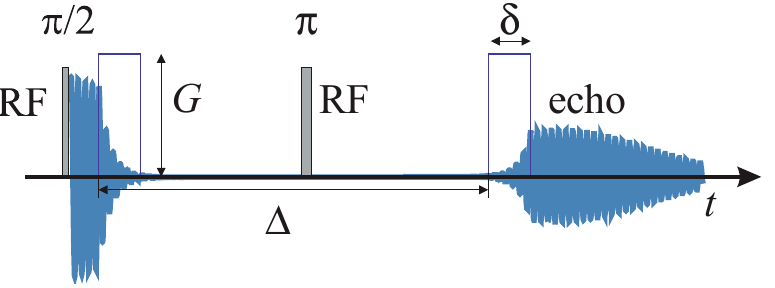
Figure 3. The PGSE sequence used to measure self-diffusion—shown are the RF and gradient pulses and the NMR signal: free induction decay at short times and echo after time Δ (blue line).